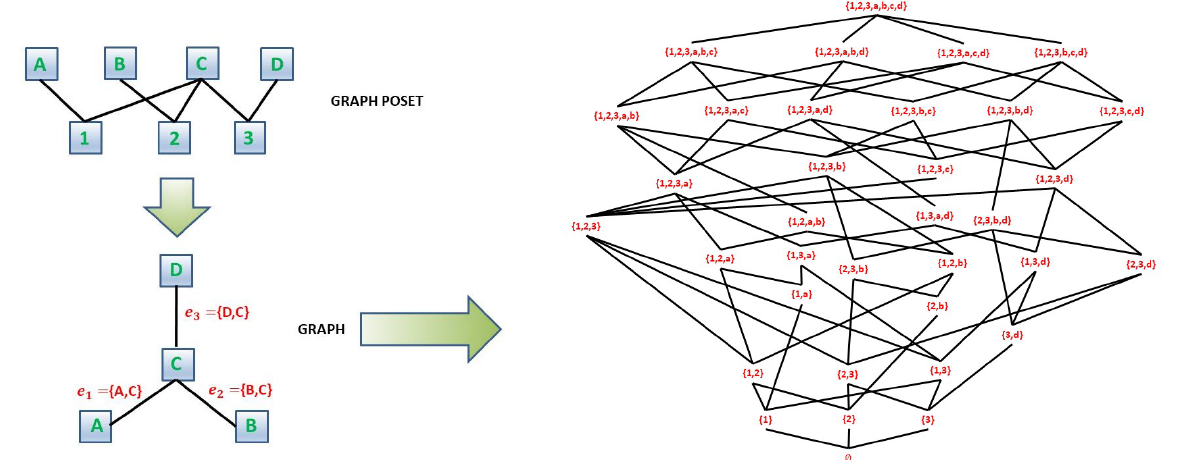
Figure 5 — A Graph Lattice